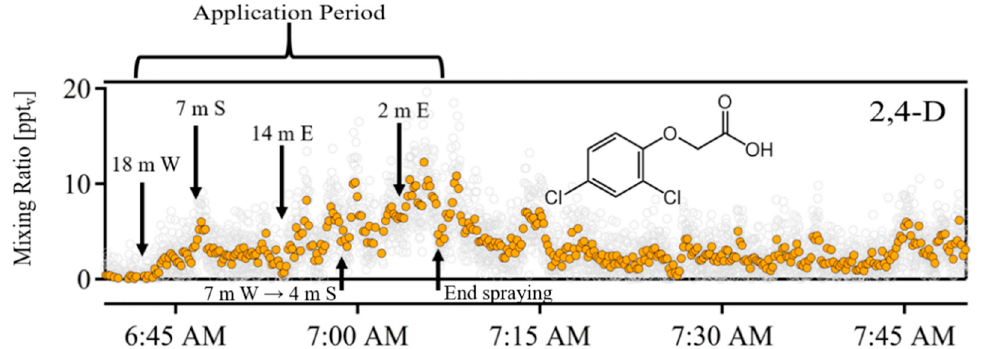
Figure 2. Time series of 2,4-dichlorophenoxyacetic acid (2,4-D) (upper panel, detected as a deprotonated molecular ion m / z 218.96) mixing ratios before, during, and immediately after the application period. Grey circles represent the 1 s data points, while colored circles are the 10 s averages. Application began at 6:42 am local time and ended at 7:08 am; each applicator pass is annotated on the time series of 2,4-D with the distance of the tractor (e.g., 18 m), and the direction of closest point of the applicator (East, West, South of the acetate-CIMS). Decreases in signal during the application period corresponded to periods when the spray boom was briefly turned off.